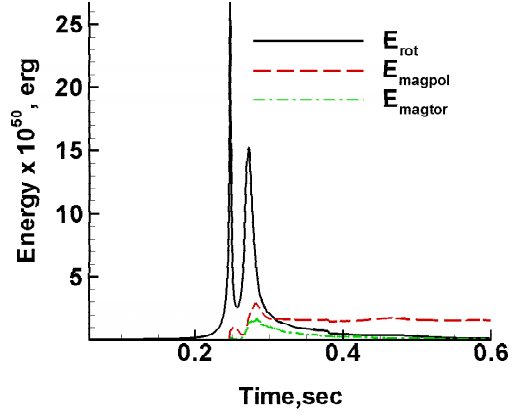
Figure 10: Time evolution of rotational energy E rot (solid line), magnetic poloidal energy E magpol (dashed line) and magnetic toroidal energy E magtor (dash- dotted line) for the case H 0 = 10 9 G , E rot 0 /E grav 0 = 1%.